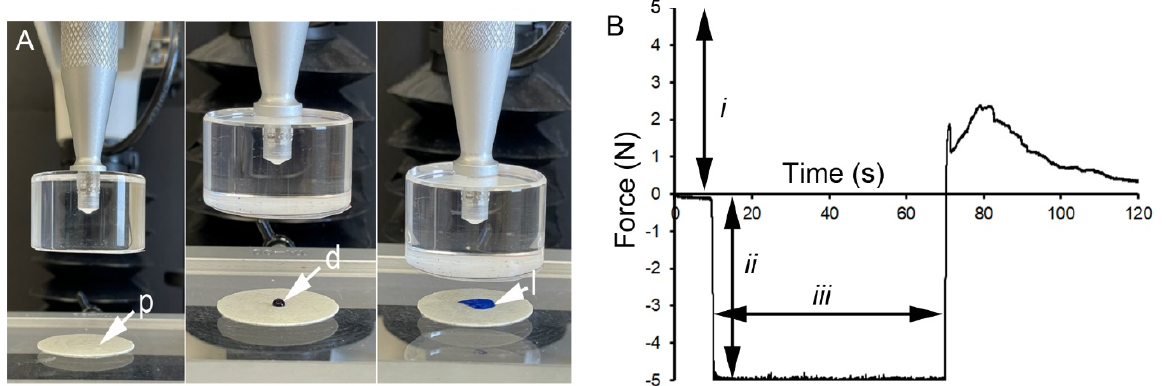
Figure 5. Active loading of the pectin films. ( A ) The pectin film (p) is attached to the fixture surface with a double ‐ sided adhesive. A 50 ul water droplet (d) containing the methylene blue tracer was placed on the pectin surface. The droplet was loaded (l) into the pectin film with an inert acrylic probe with an interface parallel to the pectin surface. ( B ) The selectable features of the loading process included the velocity of the probe ( i ), the compressive force of the probe ( ii ) and the contact time ( iii ) of probe compression. In this example, the probe velocity was 0.25 mm/s, the compression force was 5 N and the contact time was 60 s.